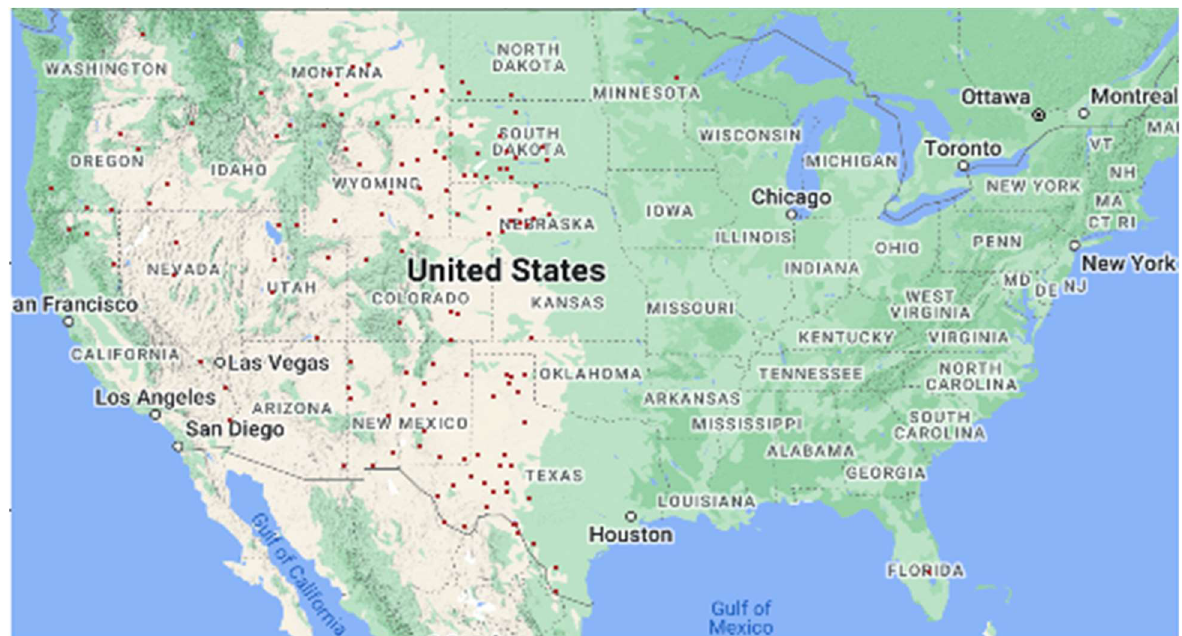
Figure 7. Cluster 5 (142 counties from 18 different